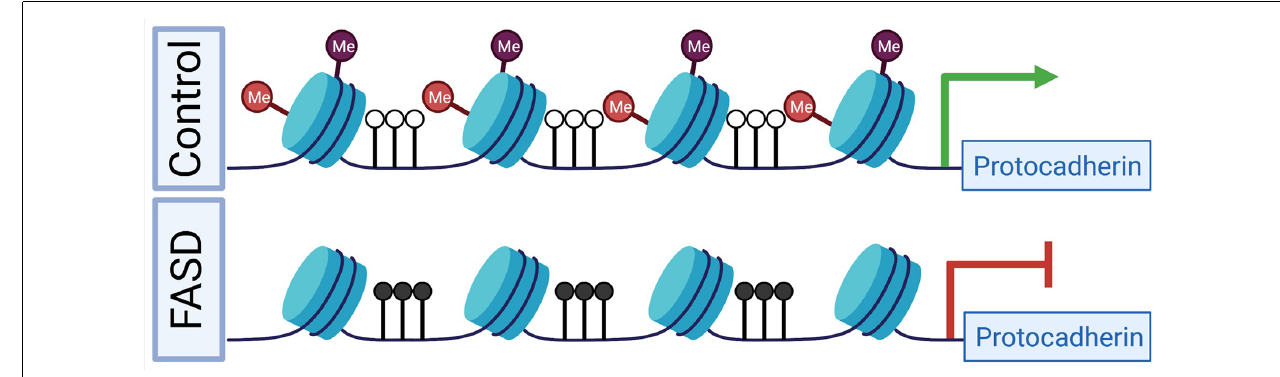
FIGURE 1 | A putative mechanism for differential epigenetic and transcriptomic profiles at the clustered protocadherin locus in fetal alcohol spectrum disorders (FASD). During development in healthy controls, the locus is marked by bivalent histone PTMs, which prevent DNA hypermethylation and poises genes for high expression levels. In FASD, prenatal alcohol exposure (PAE) results in the depletion of bivalent histone PTMs, which leads to DNA hypermethylation and reduced gene expression. Red lollipops represent H3K27me3, purple lollipops represent H3K4me3, black lollipops represent DNA hypermethylation, and white lollipops represent DNA hypomethylation. The green arrow represents normal gene expression, while the red inhibitor shape indicated reduced gene expression. Figure 1 was created with